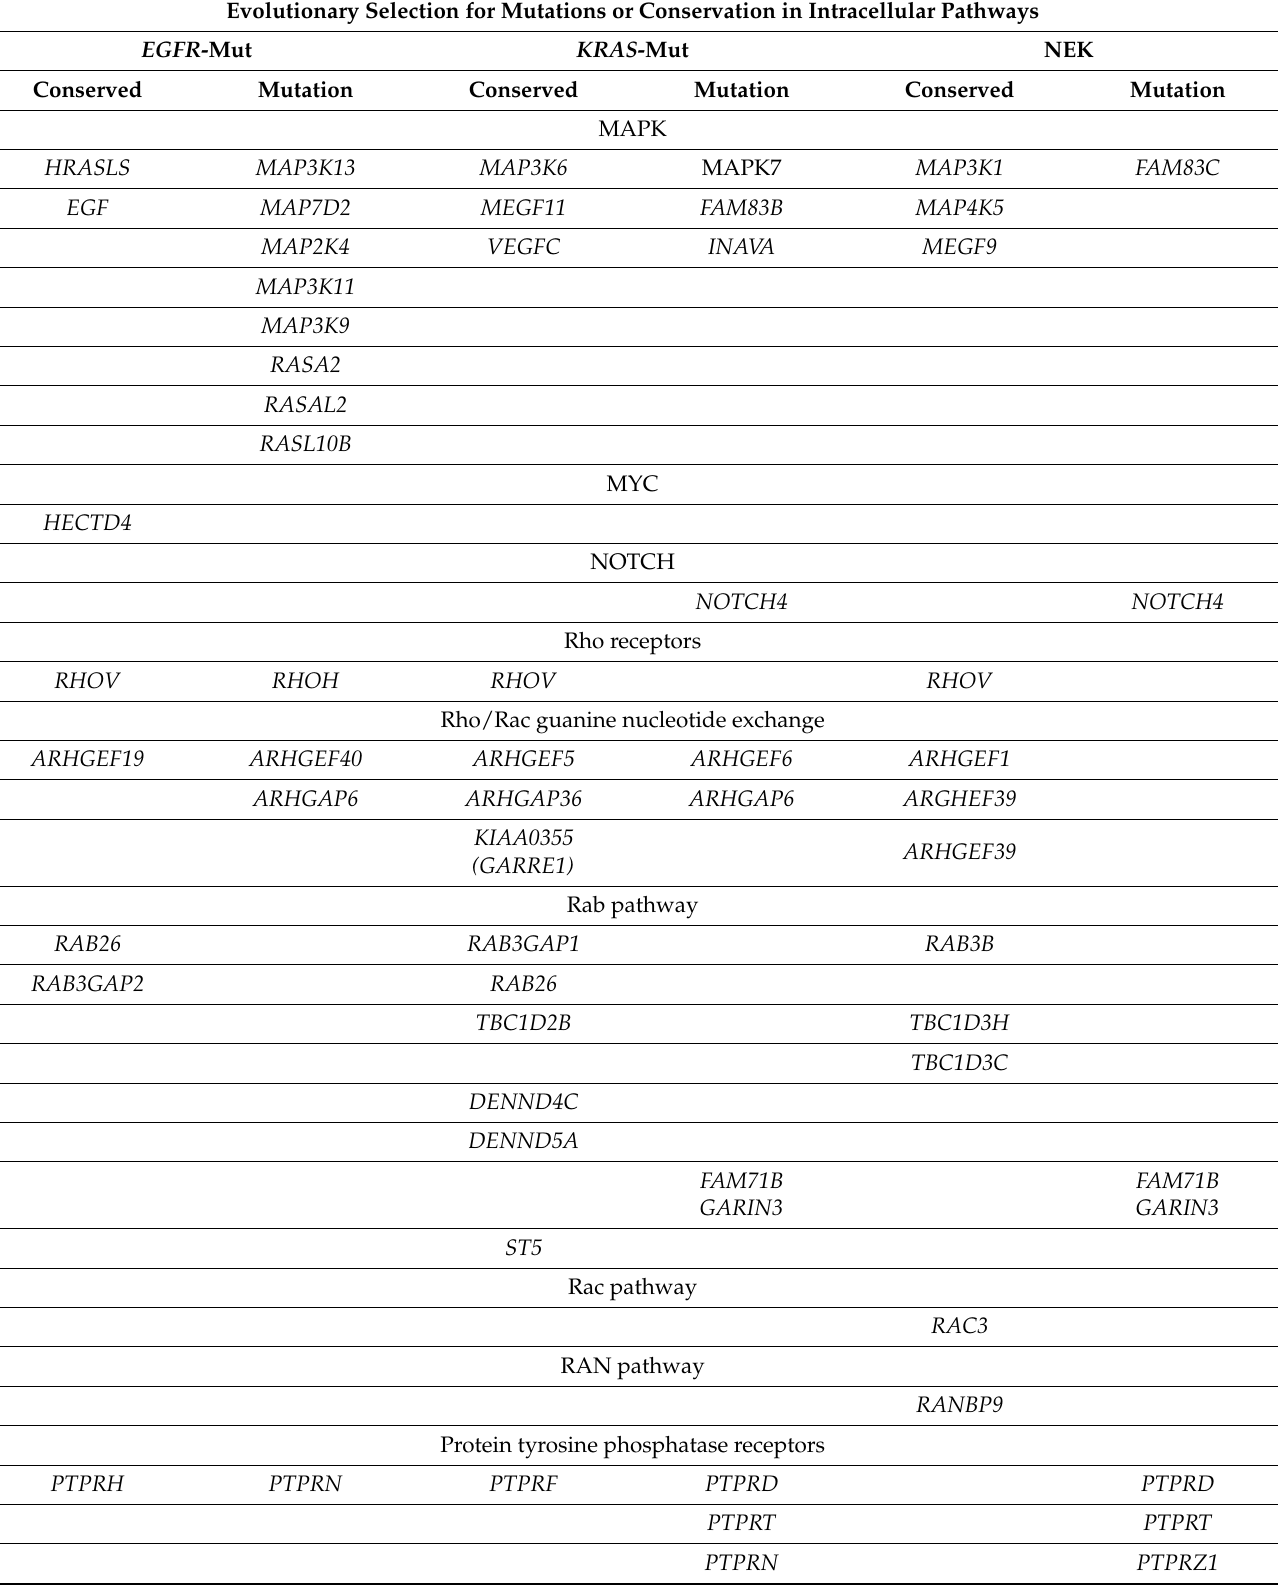
Table 1. Evolutionary selection on genes related to signaling